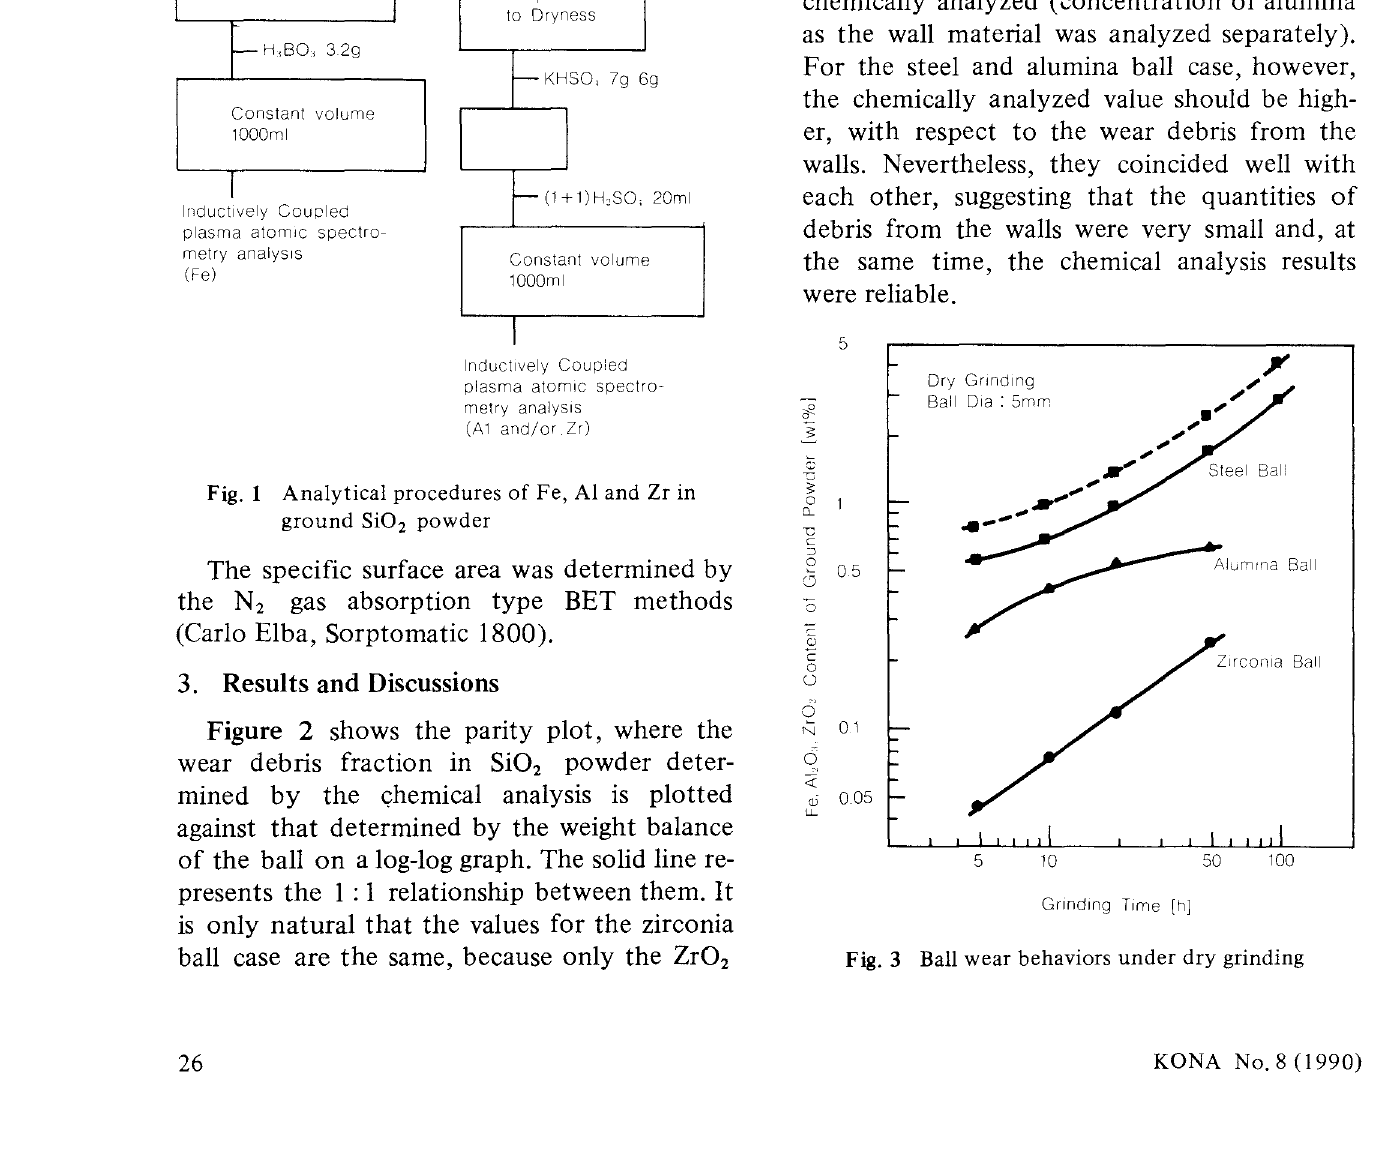
Fig. 2 Comparison of measured wear debris fraction in Si0 powder between two methods 2